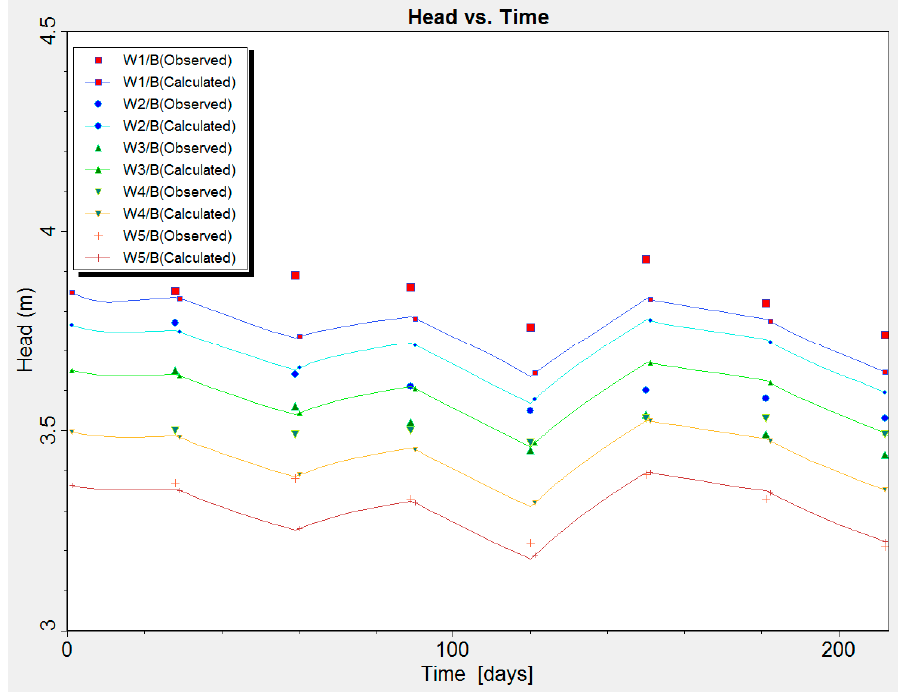
Figure 11. Calibrated head versus observed head for monitoring piezometers W1 to W5.